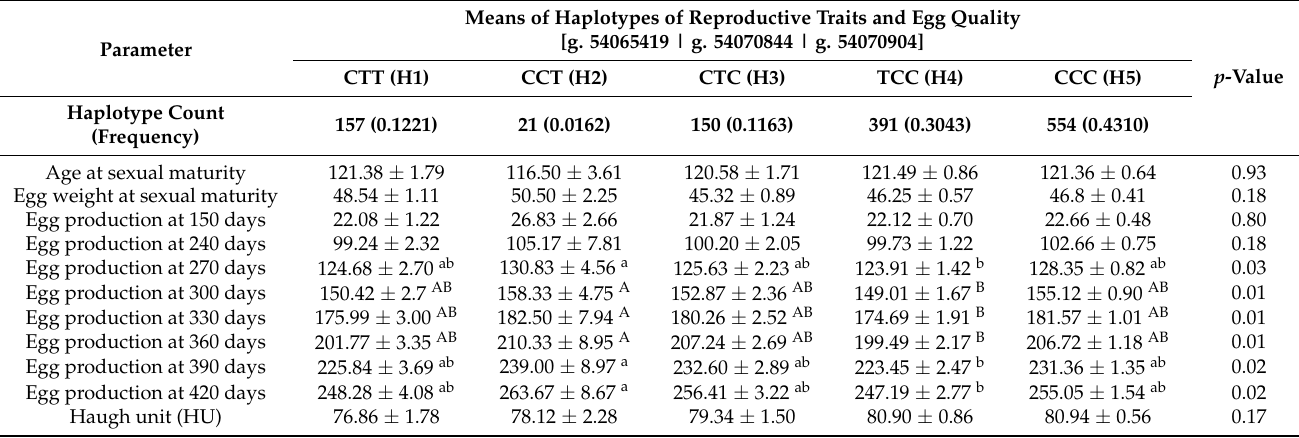
Table 4. Association between duck plumage color phenotypes and SOX10 genotypes.